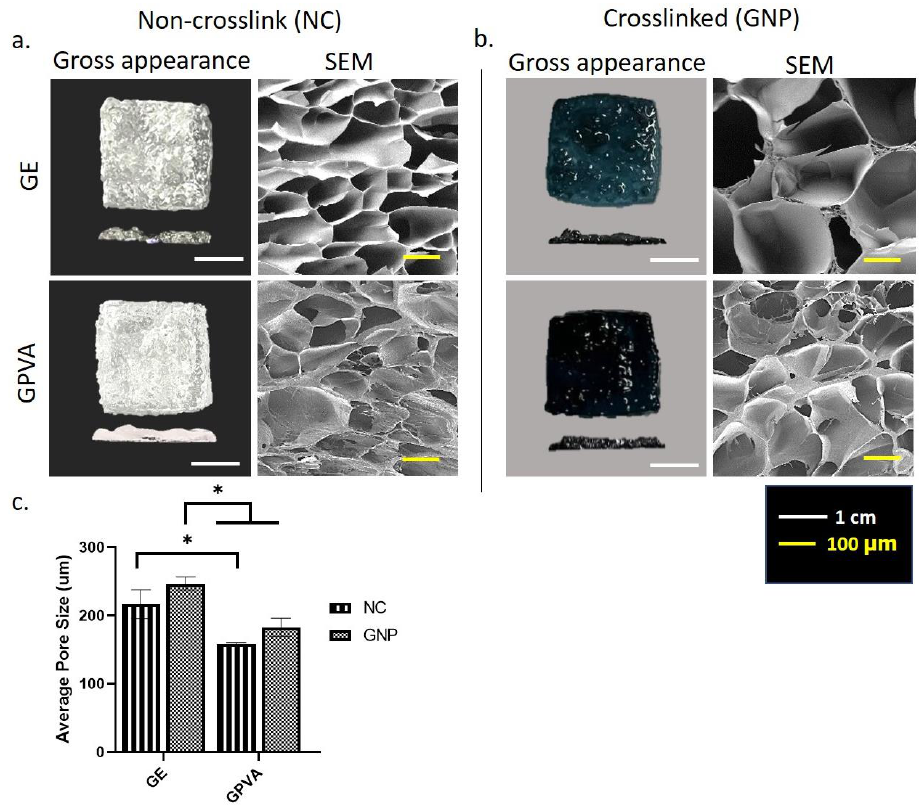
Figure 1. Gross appearance, cross-sectional microporous view and average pore sizes of single dermal layer hydrogel. ( a ) Gross appearance and SEM images of non-crosslink (NC) hydrogels. ( b ) Gross appearance and SEM images of crosslinked (GNP) hydrogels. ( c ) Average pore sizes of microporous hydrogels. * indicates p < 0.05.